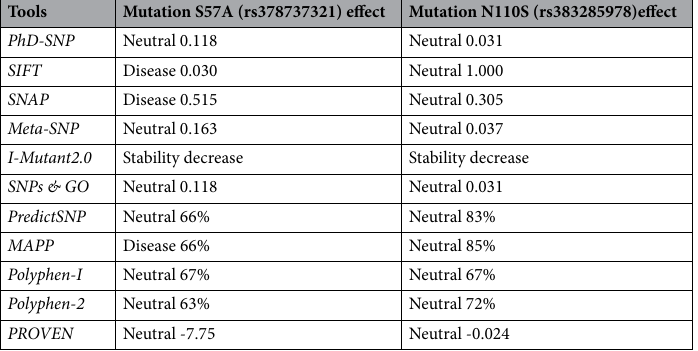
Table 2. Most advanced bioinformatics servers found that amino acid substitutions in BBD129 protein lead to a detrimental effect by decreasing the protein stability and increasing disease-causing ability.